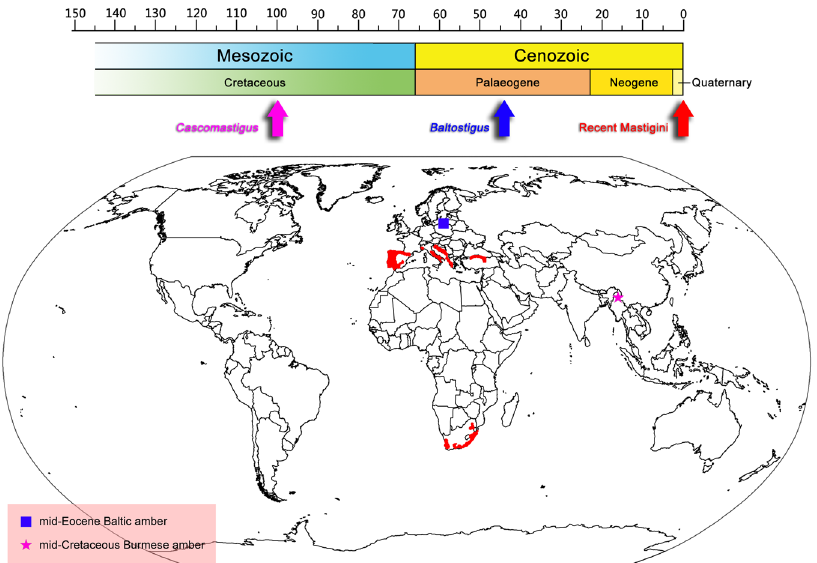
Figure 3. Spatiotemporal distribution of extant and amber-embedded Mastigini. Recent distribution of Mastigini is represented in red. Mastigini-yielding fossil localities are indicated in blue for Baltostigus (Baltic amber), and in pink for Cascomastigus (Burmese amber). The temporal distribution of fossil and extant Mastigini is indicated by arrows of the corresponding colors. (The original map source was obtained from http://www.simplemappr.net, an on-line tool for creating maps that can be freely used for publications and